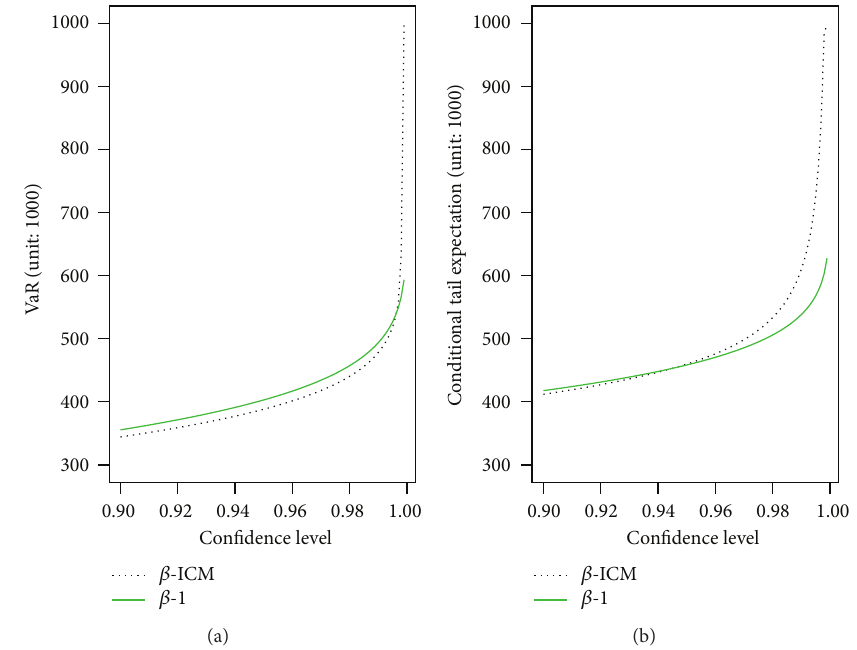
Figure 8: The approximated VaR 𝛼 and CTE 𝛼 of 𝑆 𝑛 , 𝑛 = 10 6 , the number of delinquencies in a month, at confidence levels, 0.9 ≤ 𝛼 ≤ 0.999 , based on 𝛽 -ICM and 𝛽 -I models.